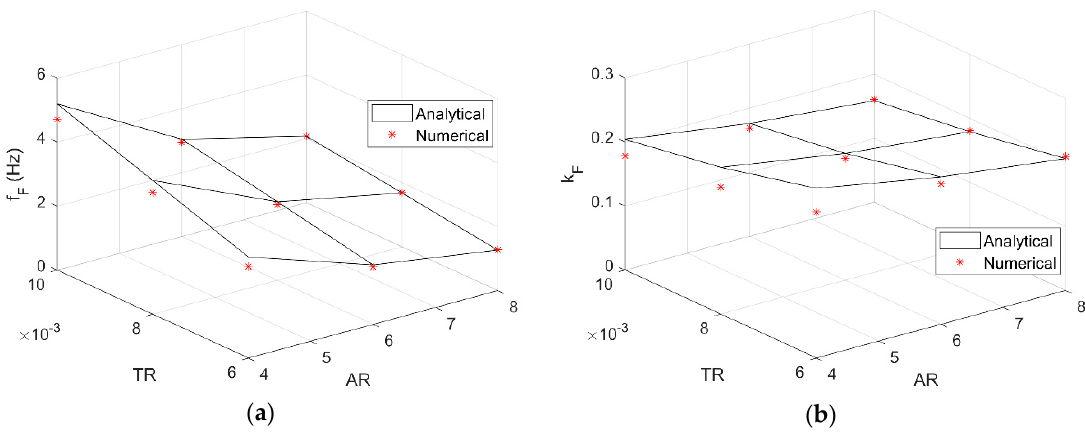
Figure 10. Flutter frequency ( a ) and reduced frequency ( b ) speeds according to MST and DLM.